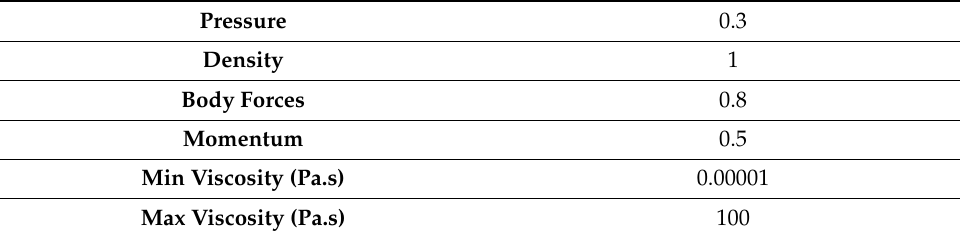
Table 3. Under-relaxation factors and viscosity limits.